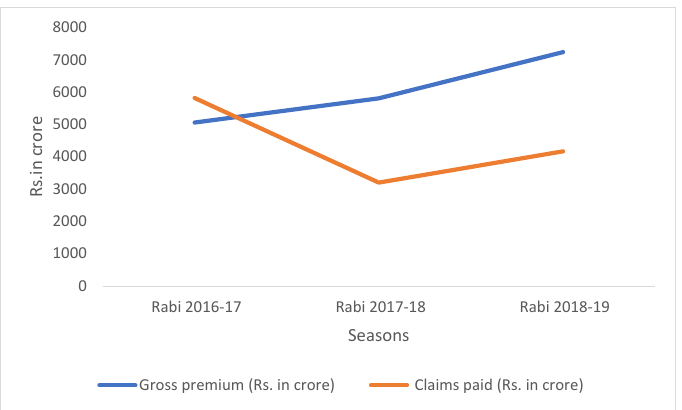
Figure 2. Gross premium collection amount and total amount of claims paid under PMFBY for rabi seasons (2016–2017 to 2018–2019). Source: Agriculture Statistics at a Glance (2017, 2018, 2019).